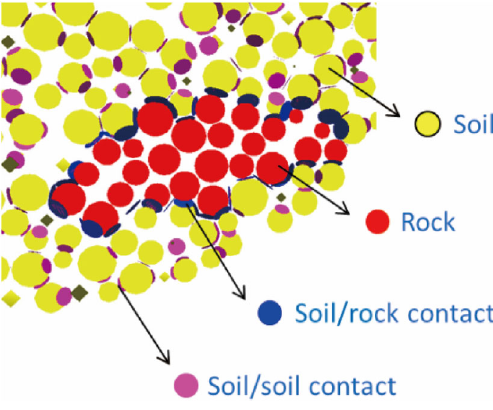
Fig. 10 Illustration of 2D soil/rock interfaces and contacts